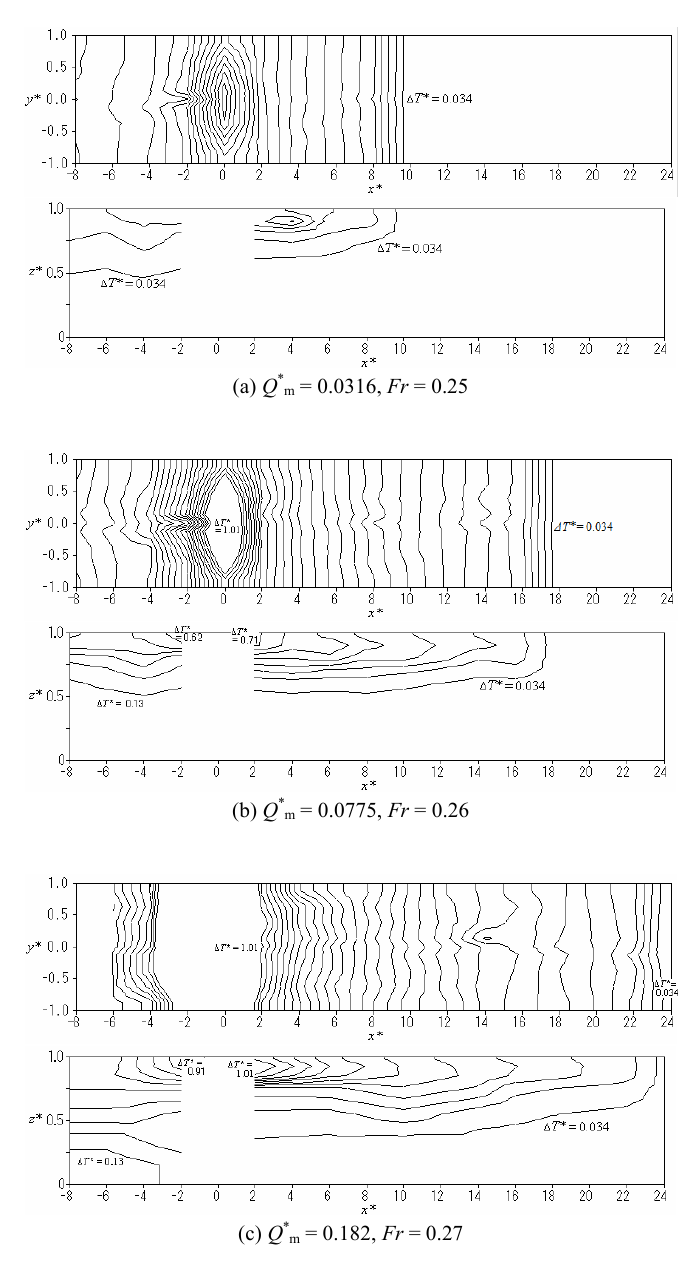
Fig. 6 Contour maps of the temperature rise at the ceiling and longitudinal section of the tunnel for three different heat release rates in the case of Froude number Fr nearly constant at 0.26. The temperature at the ceiling and longitudinal section is divided into 30 and 10 levels,